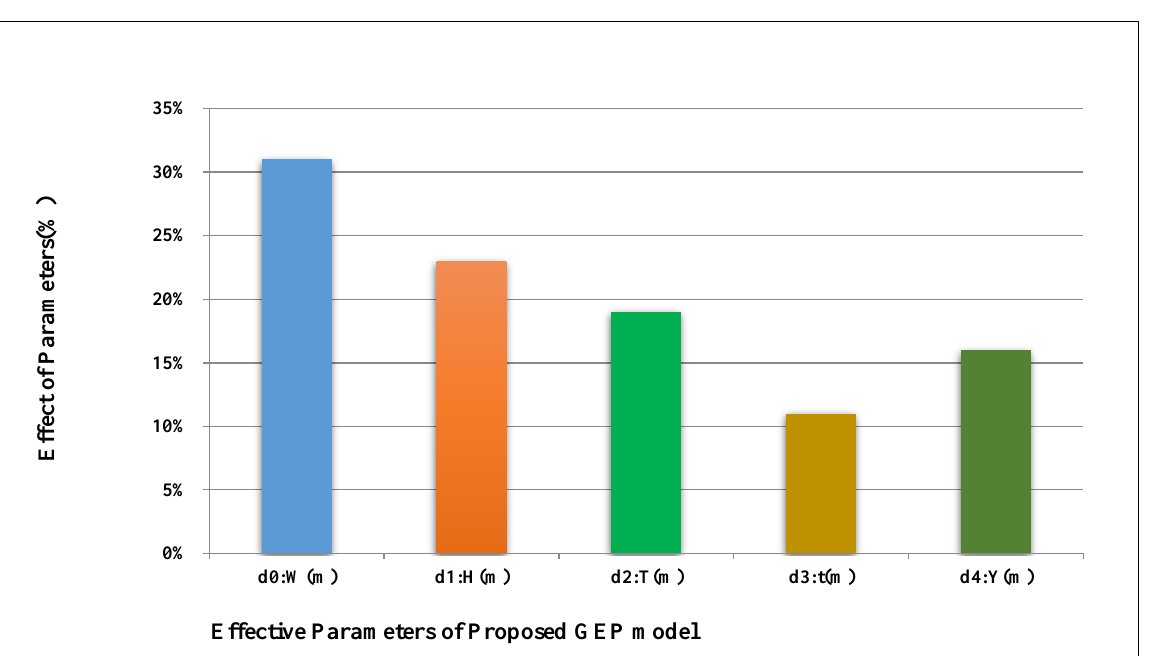
Figure 10: Sensitivity analysis results of the proposed GEP model. Source: Authors,